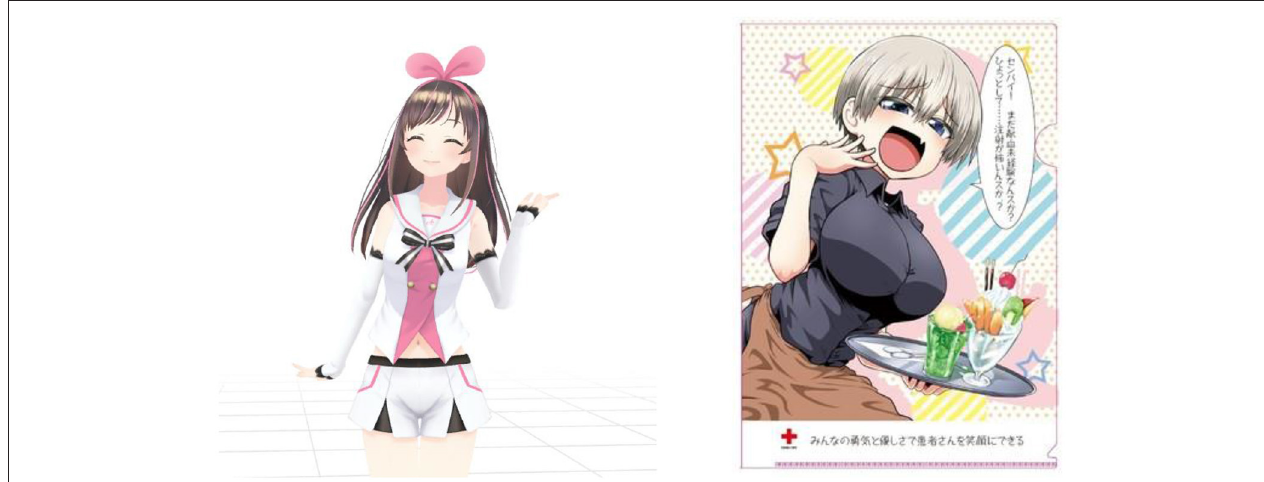
FIGURE 1 | Left: Kizuna AI (https://kizunaai.com/). Right: Uzaki-chan’s collaboration art with Japanese Red Cross for blood donation campaign. Adapted/Reproduced with permission from IVR, available at